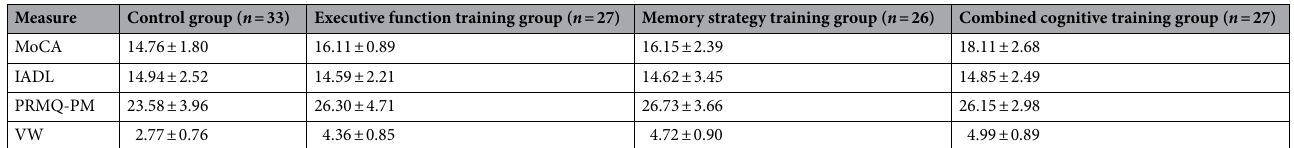
Table 7. Follow-up results of the participants (mean [M] ± standard deviation [SD]). MoCA montreal cognitive assessment scale, IADL instrumental activities of daily living scale, PRMQ‑PM prospective and retrospective memory questionnaire-prospective memory, VW virtual week task.